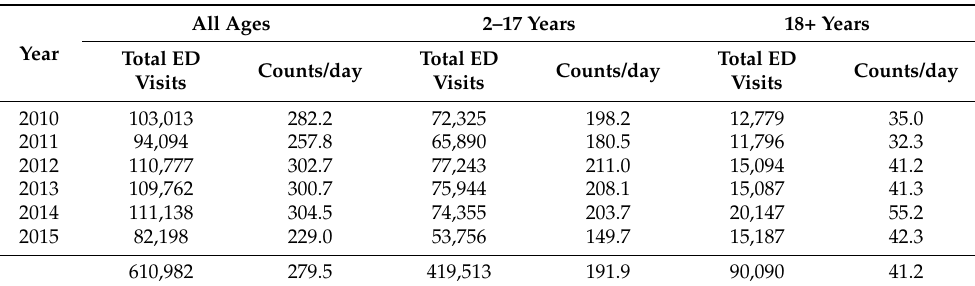
Table 1. Descriptive statistics of respiratory emergency department (ED) visits in Mexico City from 2010 to 2015, by year and age group. The total ages 2–17 years and 18+ years do not add up to the total for all ages because of the ED visits that occur in infants aged 0–1. Respiratory ED visits are defined as acute upper respiratory infections, asthma, chronic obstructive pulmonary disease (COPD), pneumonia, lower respiratory infections and other respiratory